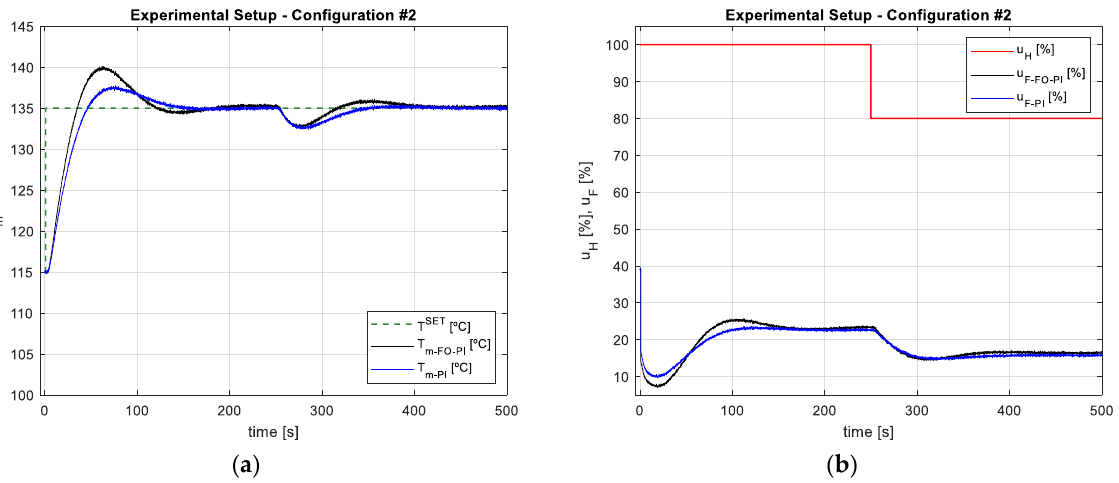
Figure 23. Closed-loop FPGA-based experimental results for servo and regulatory control, consid- ering a PI and a fractional-order PI controller: ( a ) Temperature in the heat block; ( b ) control signal u F and disturbance u H